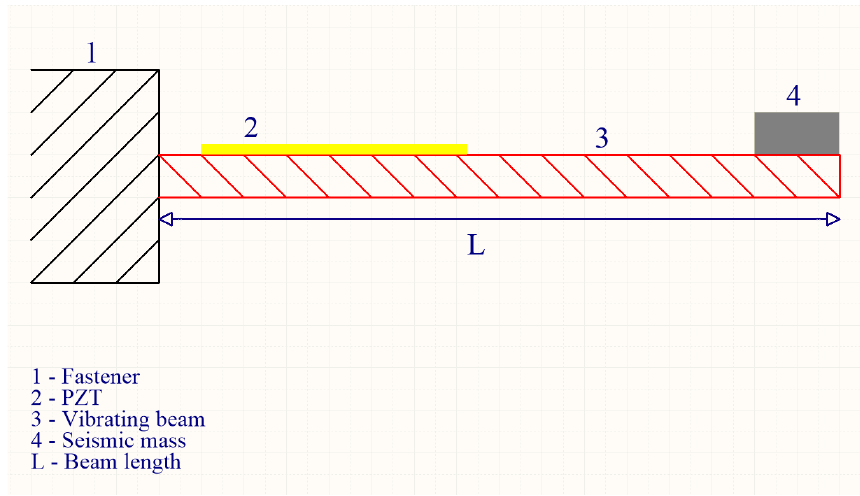
Figure 6. Principle of operation piezoelectric harvesters.